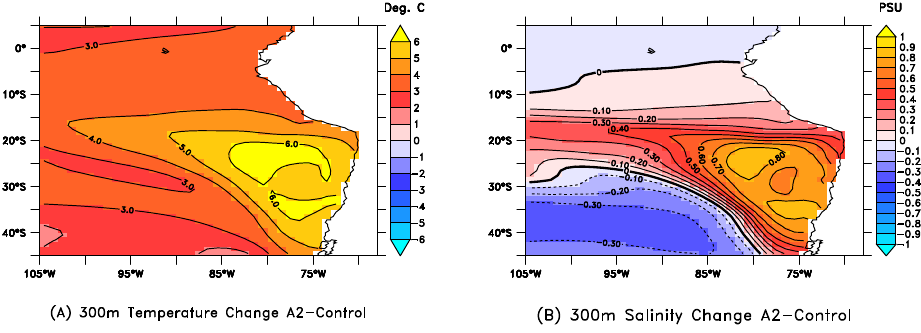
Fig. 6. (A) Change in average temperature at 300m between the A2 Scenario averaged from years 2281–2330 and the corresponding years from 1860 Control. (B) Same as A but for salinity in